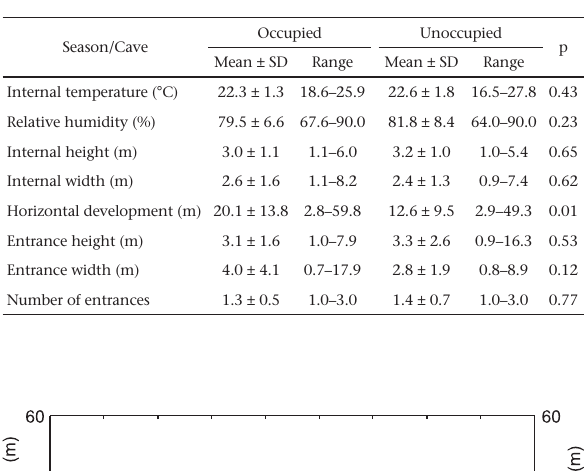
Table 2. Descriptive statistics (mean, standard deviation, range) and comparisons of means (Student’s t-test, p < 0.05) of structural characteristics (in meters) among 32 caves occupied by bats and 34 unoccupied caves at the APA karst area of Lagoa Santa, Minas Gerais, Brazil.